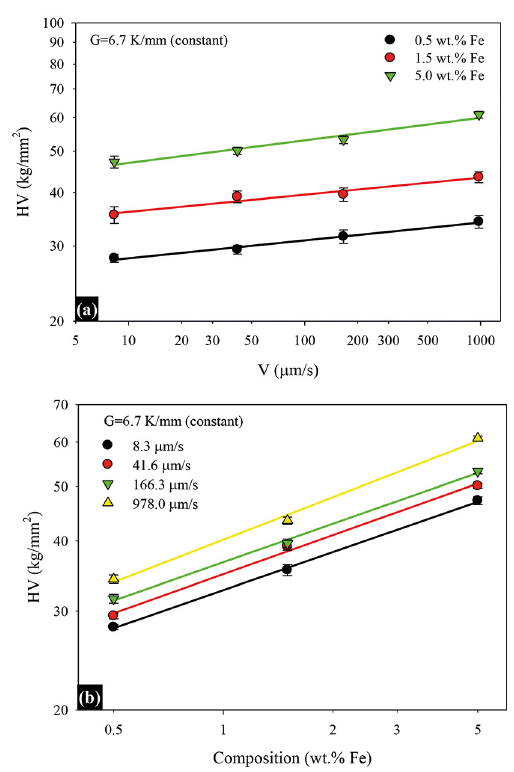
Fig. 8. (a)Variation of HV versus V for different Fe contents (b) Variation of HV versus C for different V o 0.23, 0.23, 0.24 and 0.25 for 8.3, 41.6, 166.3 and 978 μm/s